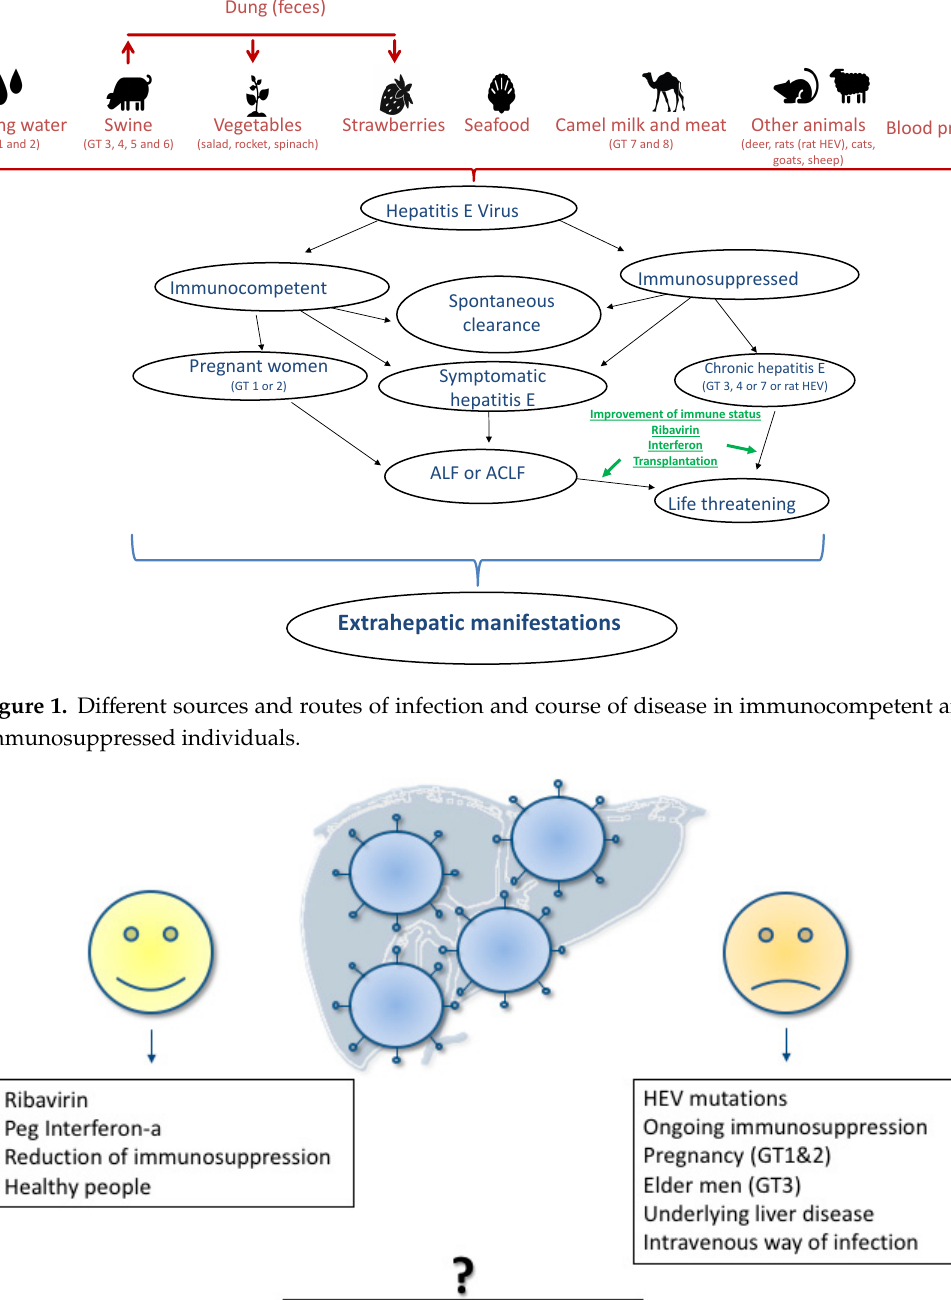
Figure 3. Schematic representation of HEV infection : In the vast majority, patients have a clinically asymptomatic course. Acute hepatitis E is generally self-limited . A minority of infected individuals develop clinically overt hepatitis E. In rare cases HEV infection can result in acute liver failure (ALF)